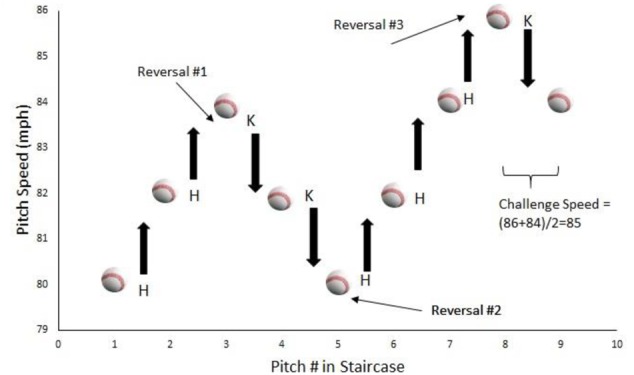
Example of the staircase procedure used for the adaptive VE training group. After each successful hit (H) the pitch speed was increased by 2 mph while after each strike (K) it was decreased by the same amount. After three reversals, the challenge speed was determined by averaging the pitch speed on the final two trials.